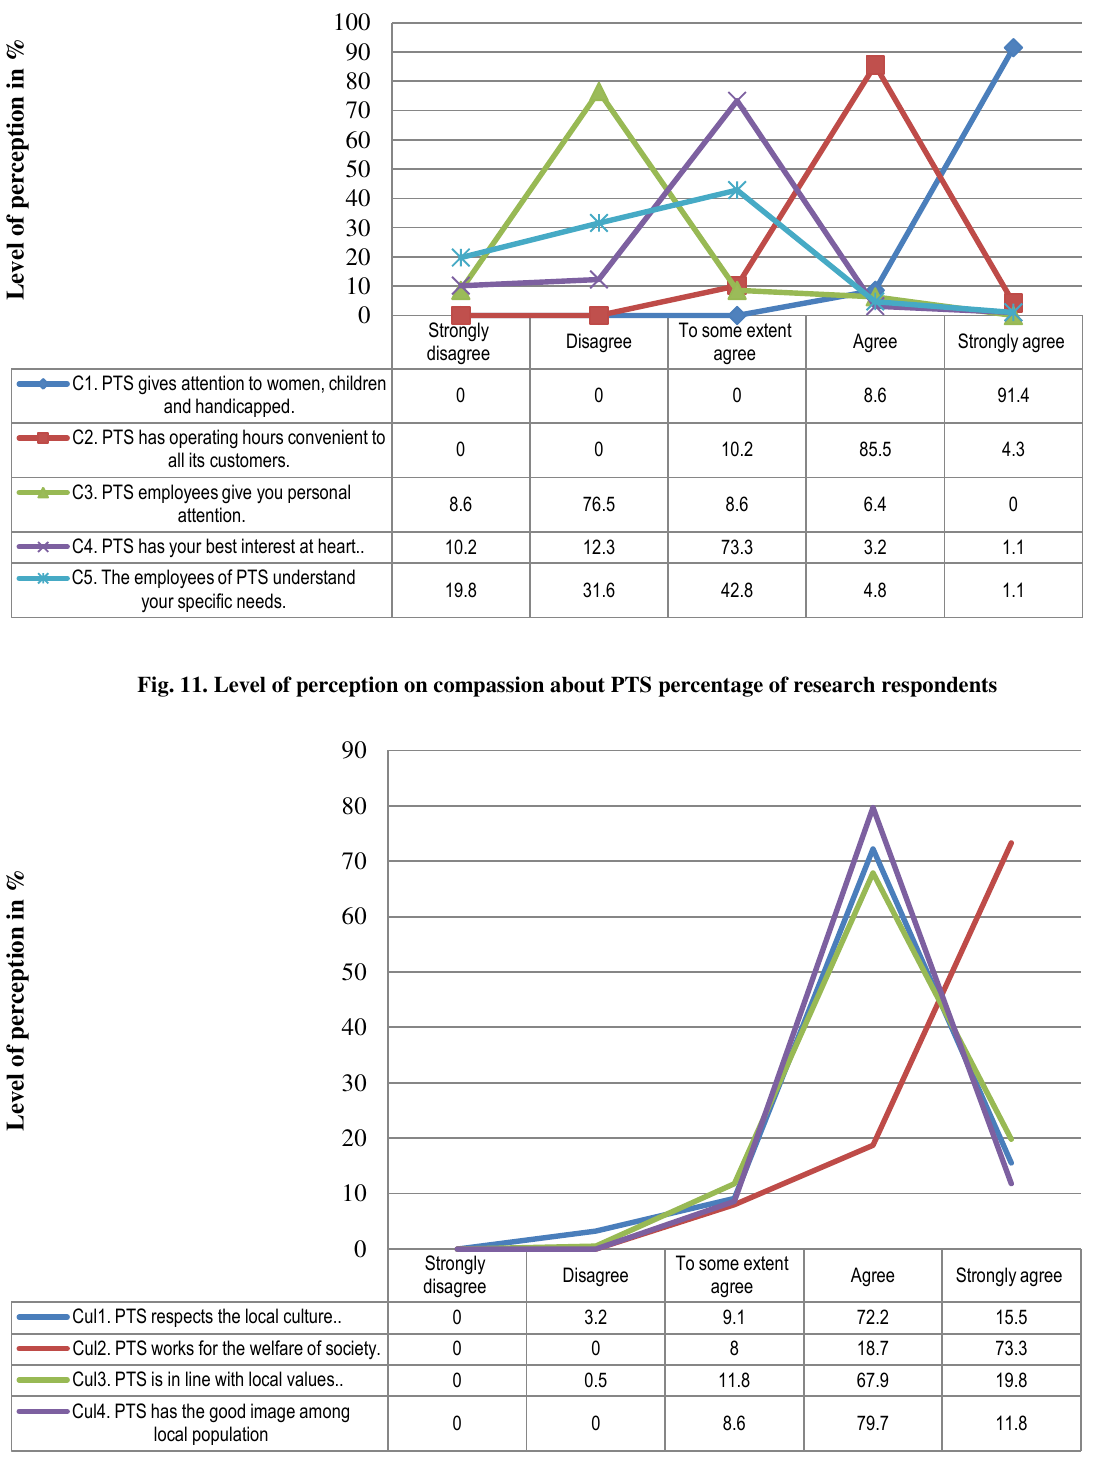
Fig. 12. Level of perception on culture about PTS percentage of research